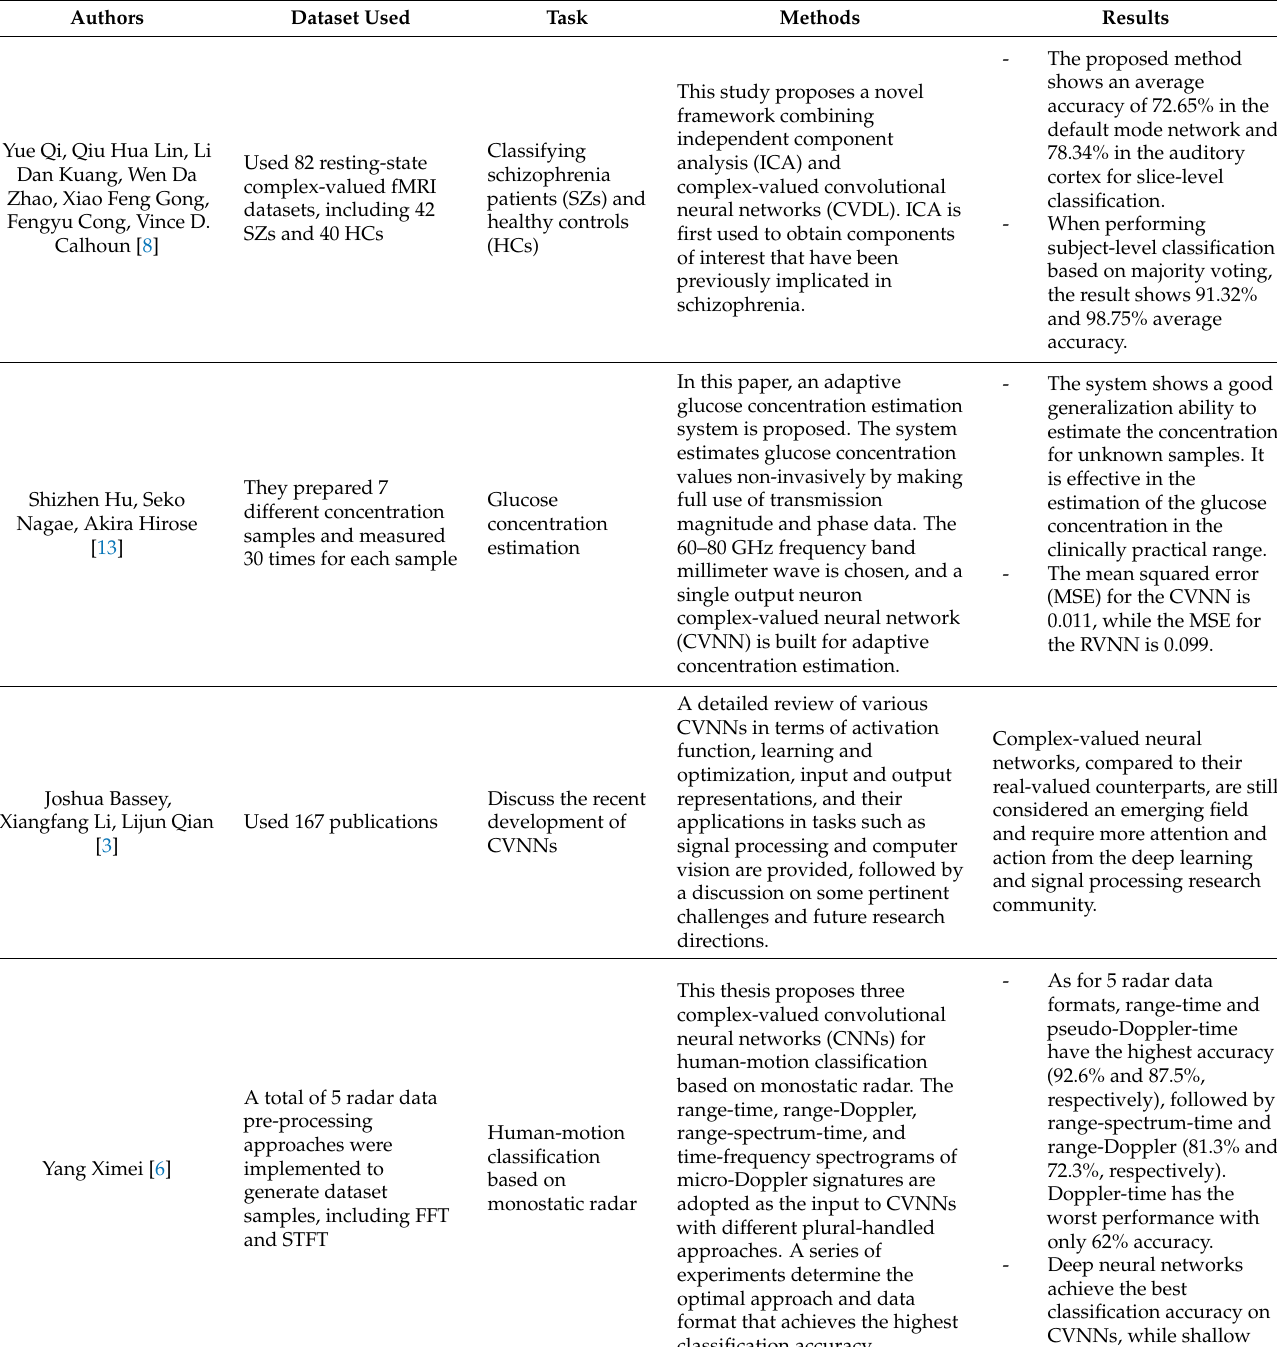
Table 1. Review of the state of the art in the most representative works related to the use of complex- valued neural networks for classification